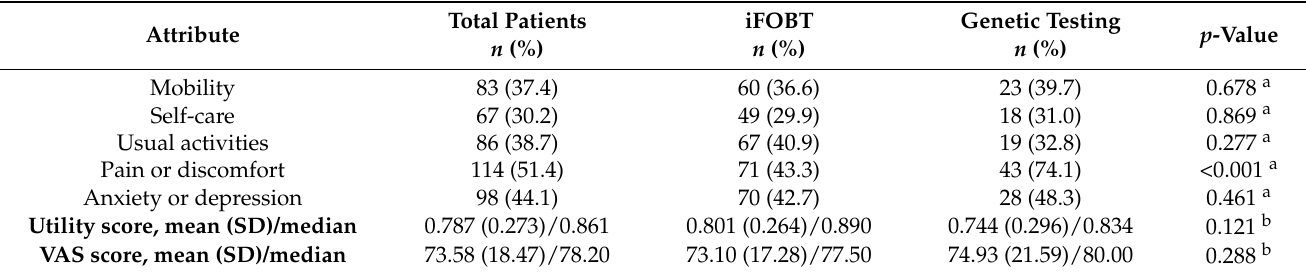
Table 3. Proportions of problems reported in the EQ-5D-5L dimensions and the patients’ utility and VAS scores ( n = 200).